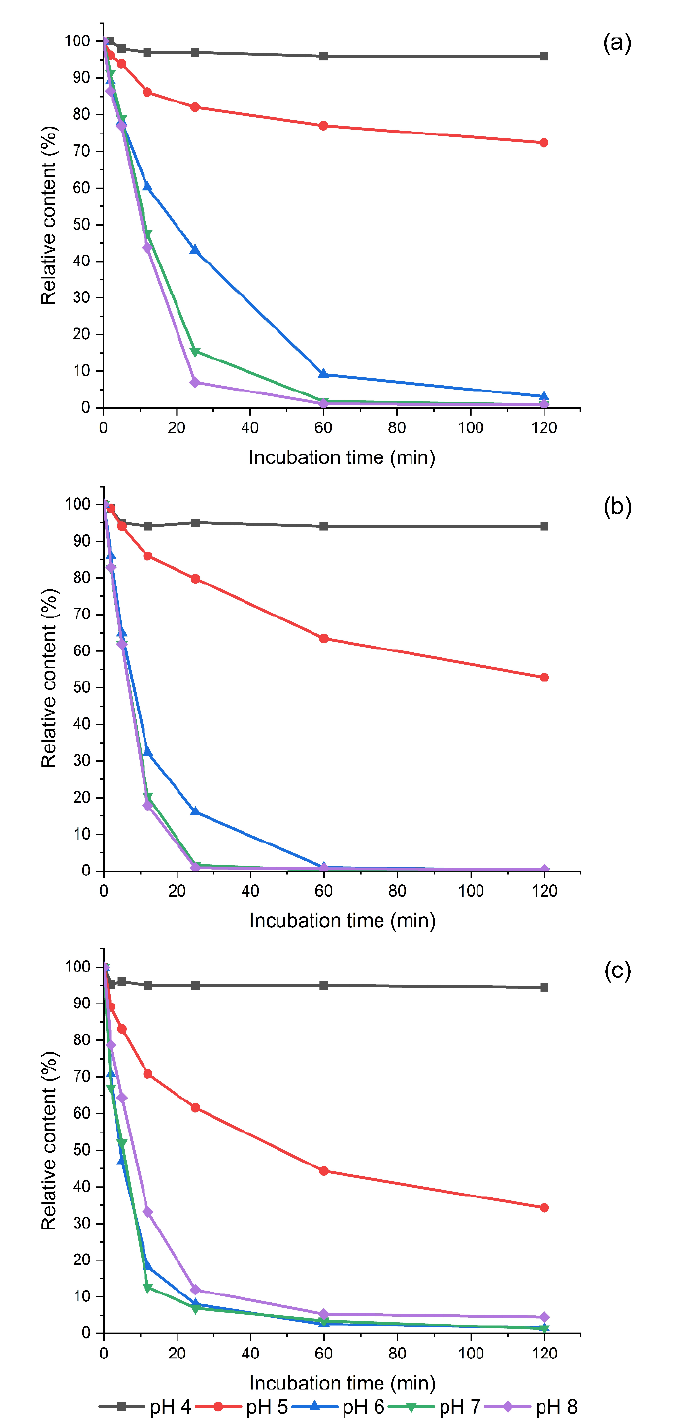
Figure 4. Time-dependent degradation of ( a ) putrescine, ( b ) cadaverine, and ( c ) tyramine by homogenized fenugreek sprouts at different pH values.